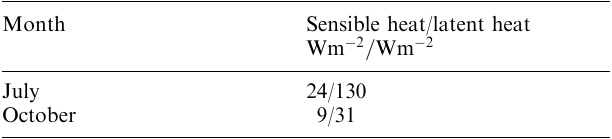
Table 12. Bowen ratios for July and October, southern Germany used in the calculations